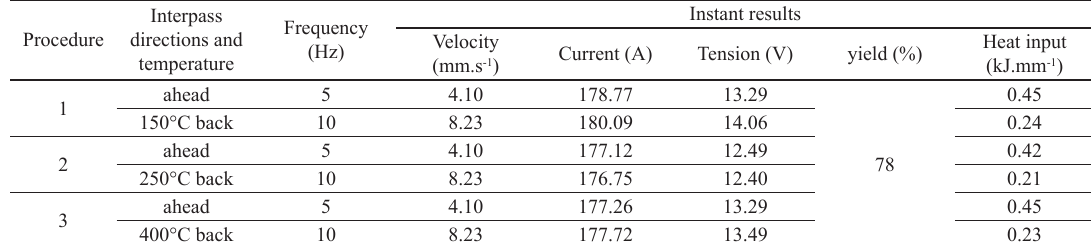
Figure 1. General assembly of the tube sample welding: a) Positioning of thermocouples for measuring the temperature during the TIG welding process, b) Locations of the sample’s extractions. Table 2. Parameters of the autogenous TIG welding